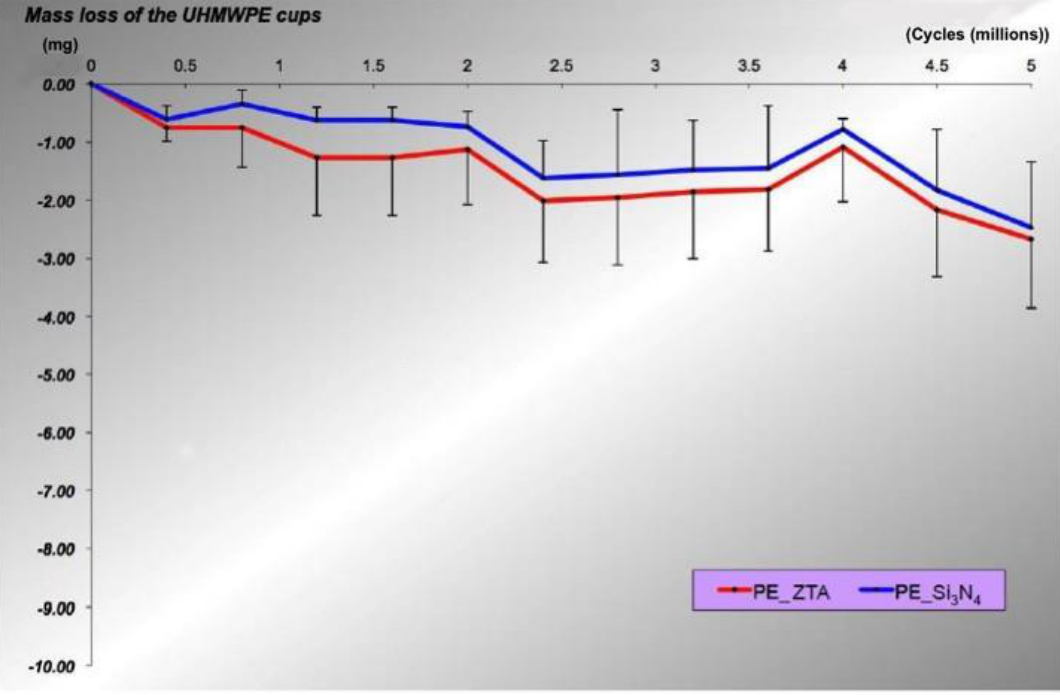
Figure 2. Comparison of total mass loss over 5 million cycles (Mc) of simulated gait between PE_ZTA and PE_ Si 3 N 4 bearing couples. Table 1. Comparisons of cumulative weight loss of Vit-E XLPE acetabular cups coupled with ZTA (BIOLOX ® delta ) and Si 3 N 4 ( MC2 ® ). p -values were evaluated by a non-parametric Mann–Whitney U